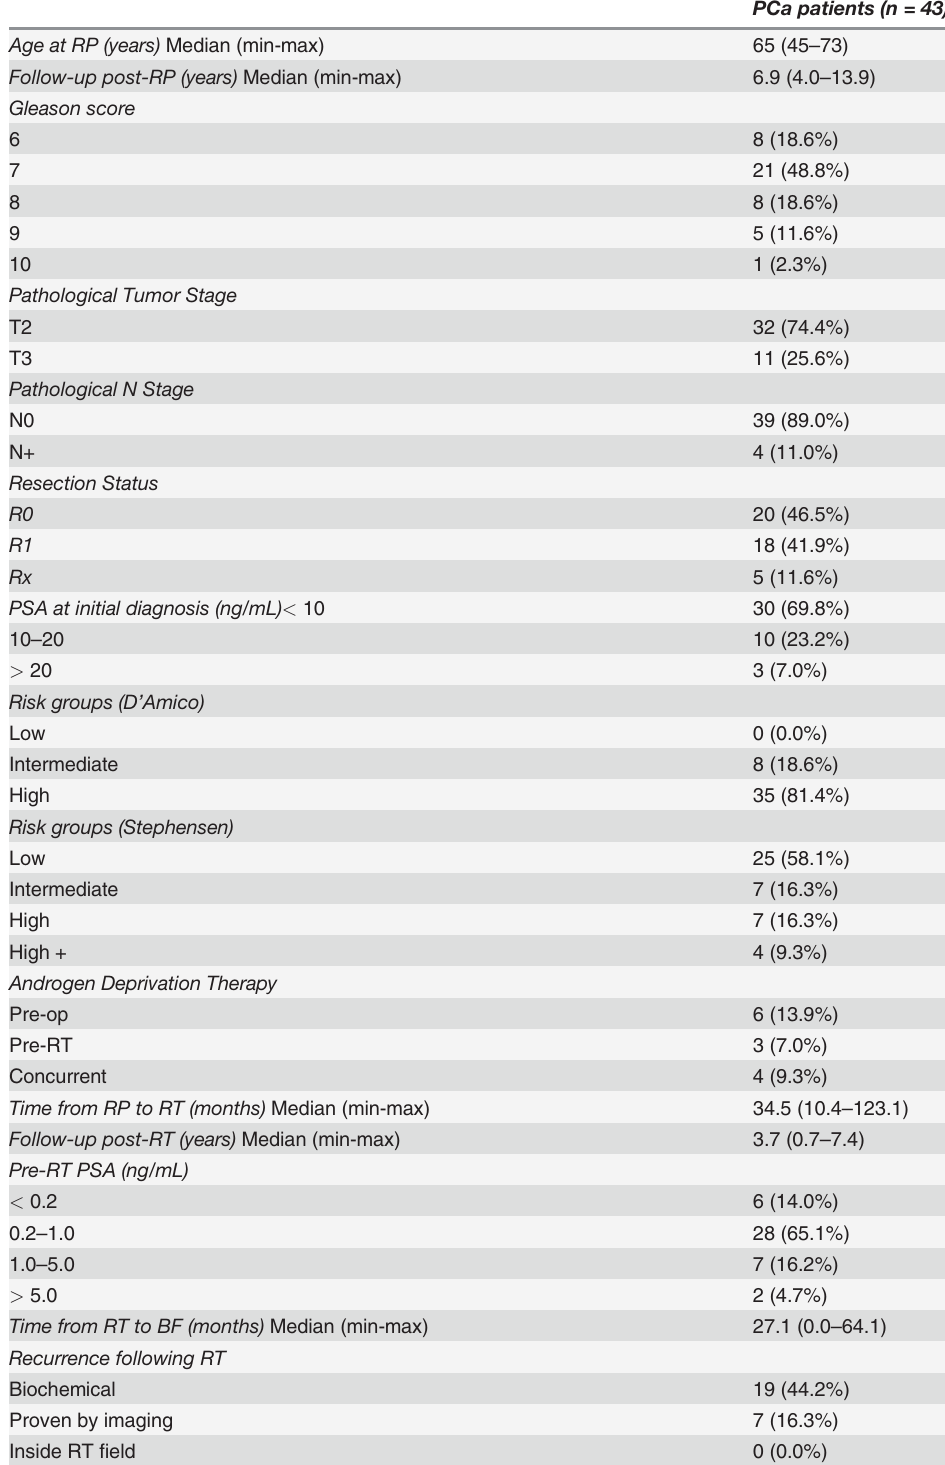
Table 1. Clinical characteristics of 43 prostate cancer patients treated with salvage radiation therapy